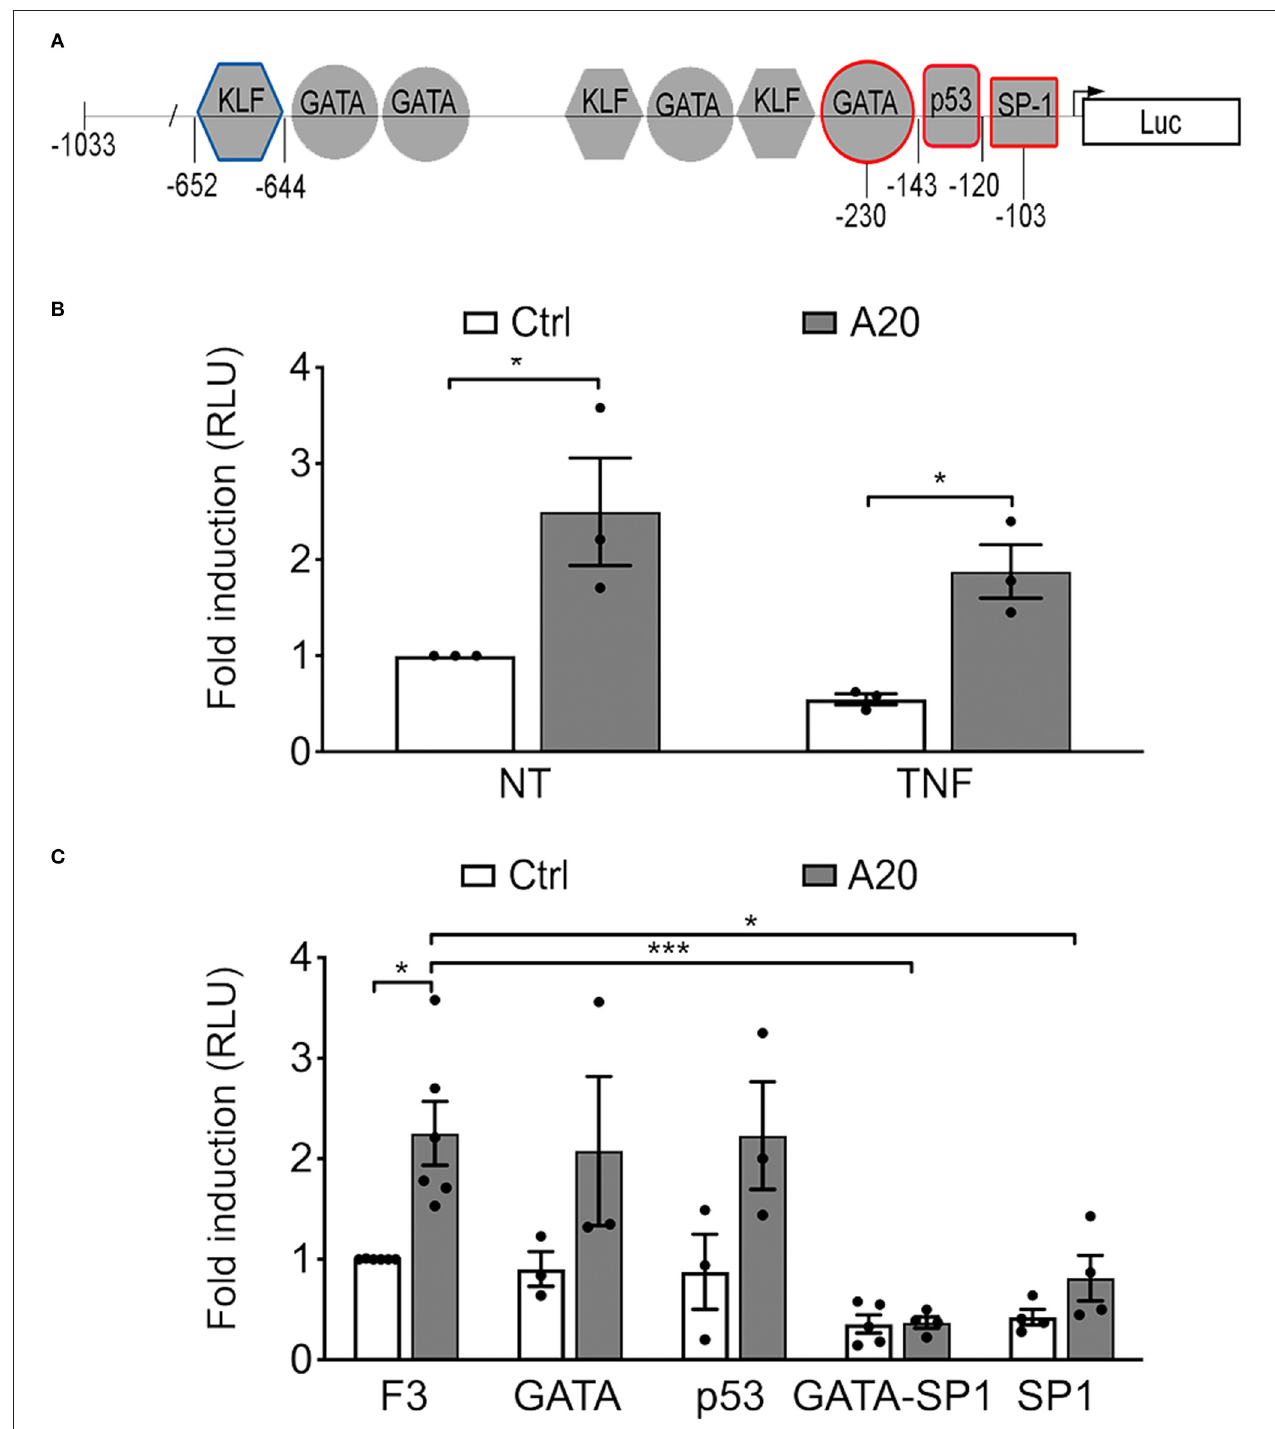
FIGURE 2 | A20-induced eNOS upregulation is transcriptional but independent from GATA, SP1, and p53 binding sites in the eNOS promoter. (A) Schematic representation of the truncated F3-Luciferase eNOS promoter construct, encompassing 1,033 bp of the DNA sequence upstream of the transcription start site. Geometrical forms indicate transcription factor binding sites for Krüppel-like factor (KLF), GATA, p53, and SP1, up to position − 652. Red markings indicate sites mutated to prevent binding of the respective transcription factor. These mutants were used in experiments shown in (C) . The blue marking depicts the prime KLF binding site in the eNOS promoter. (B,C) Bovine aortic endothelial cells (BAEC) were co-transfected with various eNOS truncation or point mutant promoter constructs, an RSV-driven β gal reporter, used to correct for transfection efficiency, and either pcDNA3.1-A20 (A20) expression plasmid or an empty pcDNA3.1 vector (Ctrl). Cell lysates were recovered 48h after transfection and used to measure luciferase and β -galactosidase activities. (B) BAEC transfected with the F3-Luc